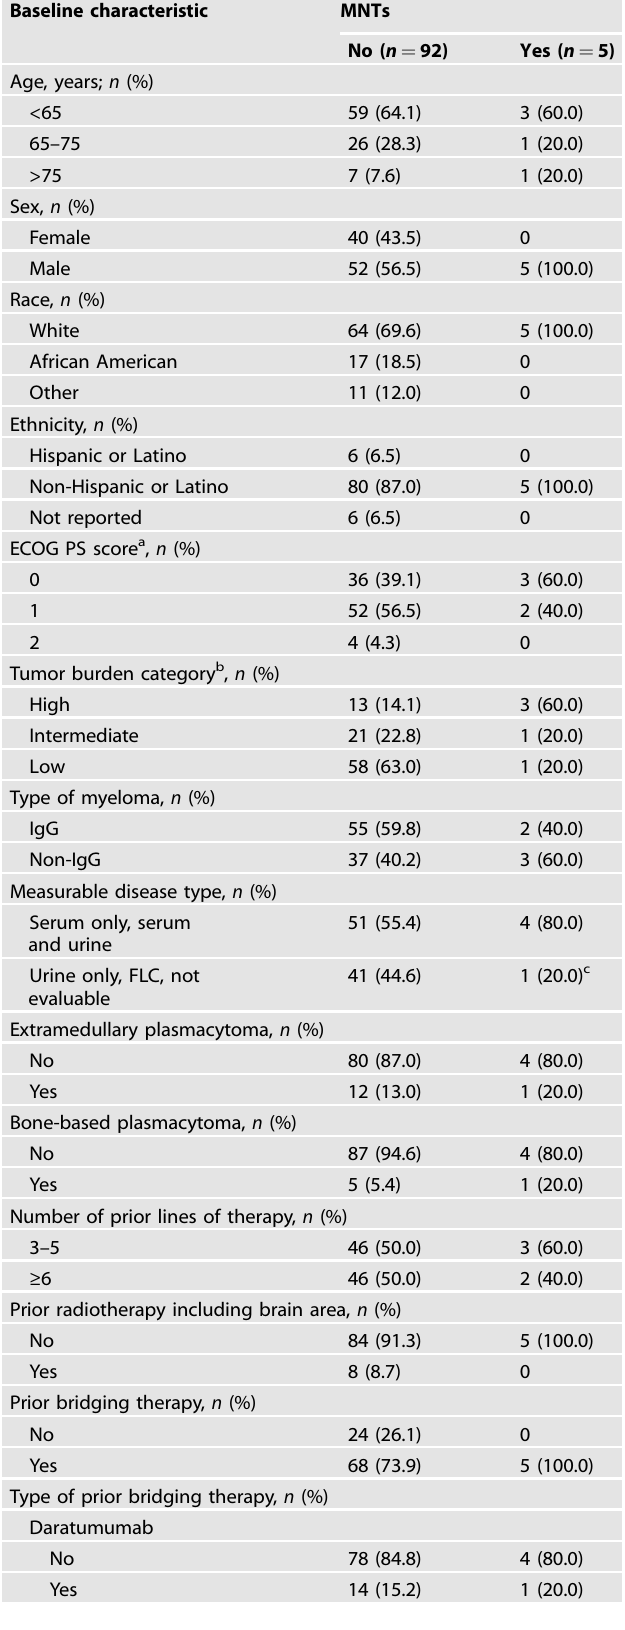
Table 3. Baseline and post-infusion characteristics in patients with and without MNTs in CARTITUDE-1.